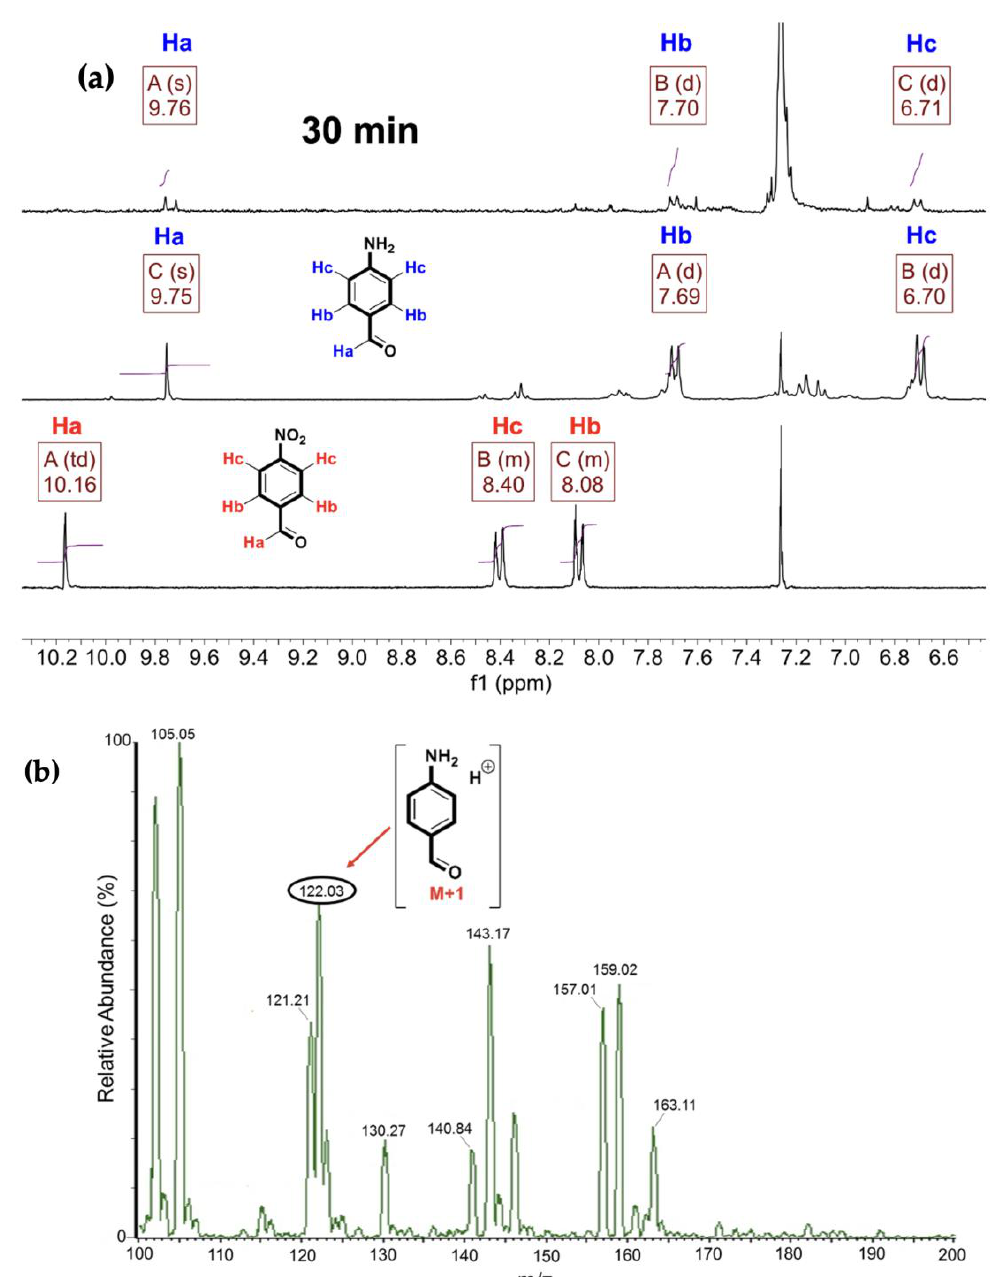
Figure 7. ( a ) from bottom to top the spectra of 4-nitrobenzaldehyde (NBA), 4-aminobenzaldehyde (ABA) and crude of reaction after 30 min of irradiation; ( b ) on right the ESI-MS spectrum of crude of reaction after 30 min.